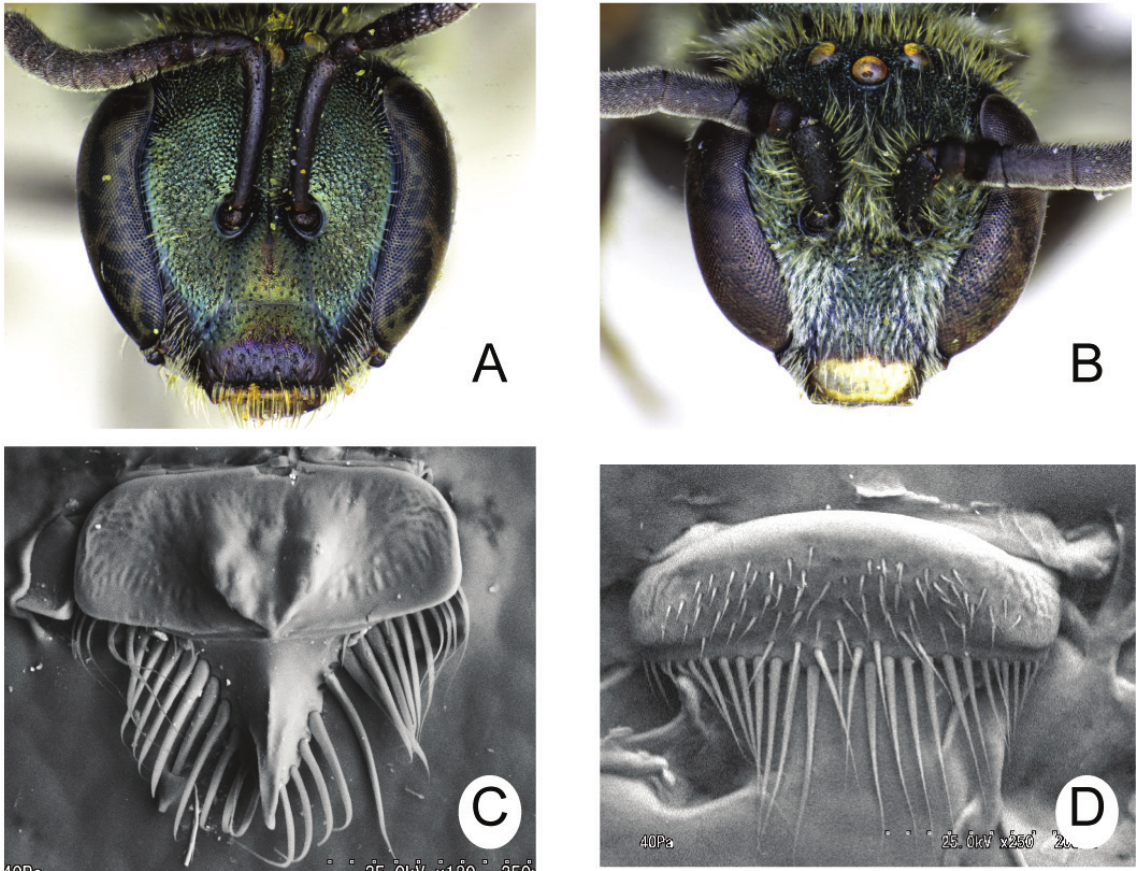
Fig. 15. Lasioglossum ( Dialictus ) problematicum (Blüthgen, 1923). A–B . head. C–D . Labrum. a, C. ♀. B, D.